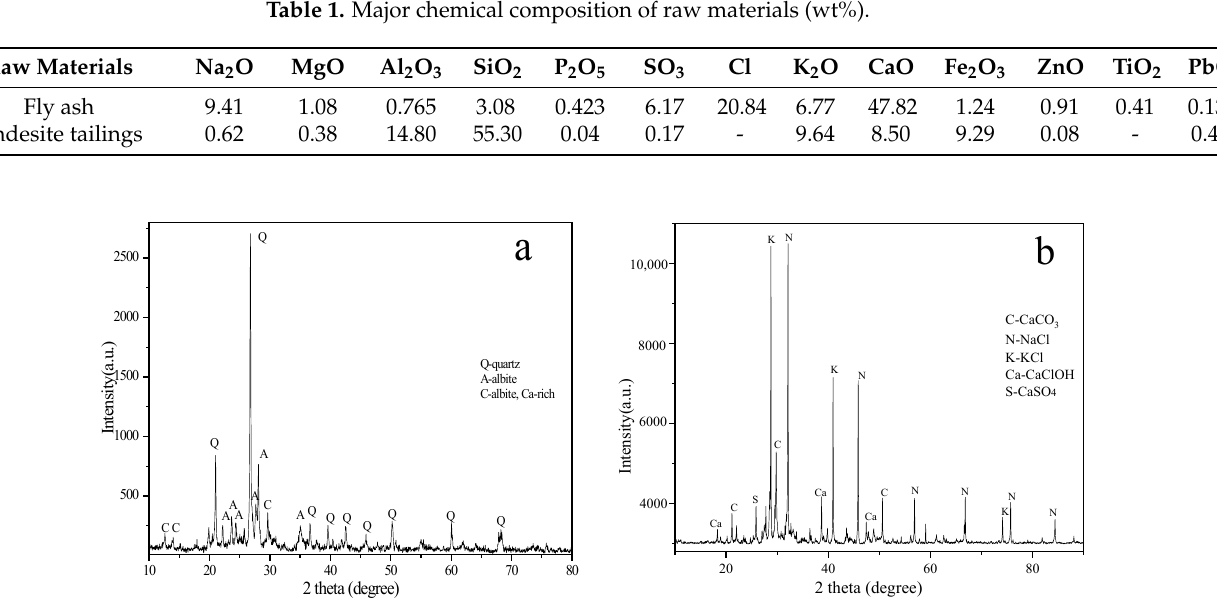
Figure 1. XRD patterns obtained from andesite tailing ( a ) and MSWI fly ash ( b ).